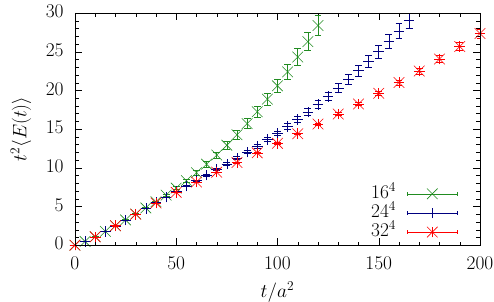
Figure 3. The dimensionless quantity t 2 x E p t qy as a function of t { a 2 on the 16 4 , 24 4 and 32 4